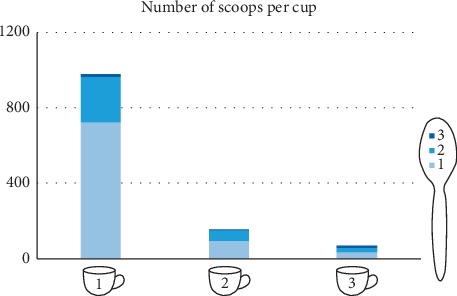
Analyses of survey questions (how many cups do you consume per day, and how many scoops of herb do you use per cup?).